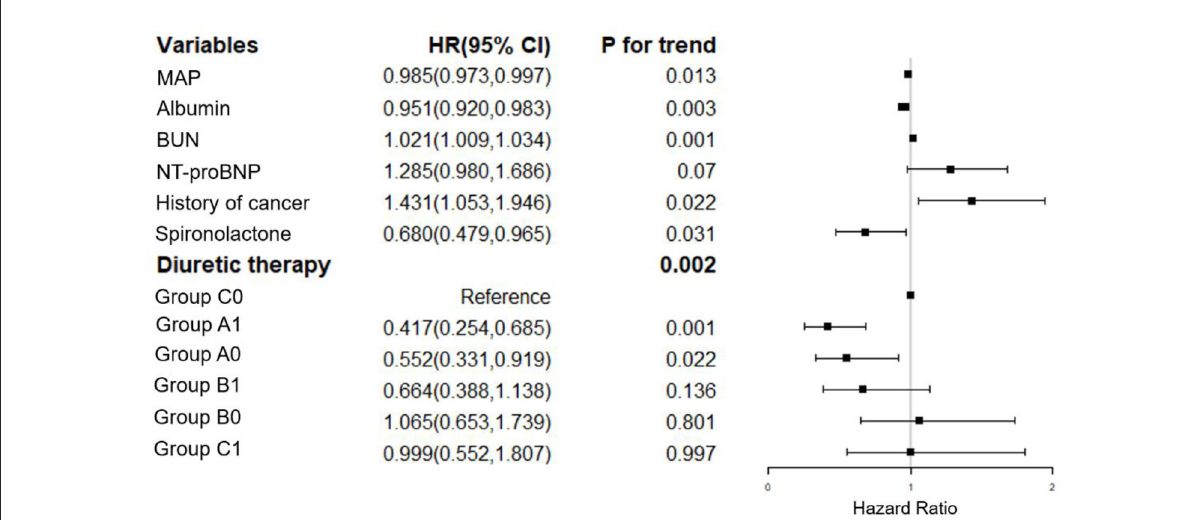
FIGURE3 Cox regression analysis of the associations between 90-day cumulative mortality and the clinical findings. MAP, mean arterial pressure; NT-proBNP, N-terminal pro-B-type natriuretic peptide. Group A1: < 100 mg/d equivalent doses of furosemide plus TLV; Group A0: < 100 mg/d equivalent doses of furosemide only; Group B1: ≥ 100 and < 200 mg/d equivalent doses of furosemide plus TLV; Group B0: ≥ 100 and < 200 mg/d equivalent doses of furosemide only; Group C1: ≥ 200 mg/d equivalent doses of furosemide plus TLV; Group C0: ≥ 200 mg/d equivalent doses of furosemide